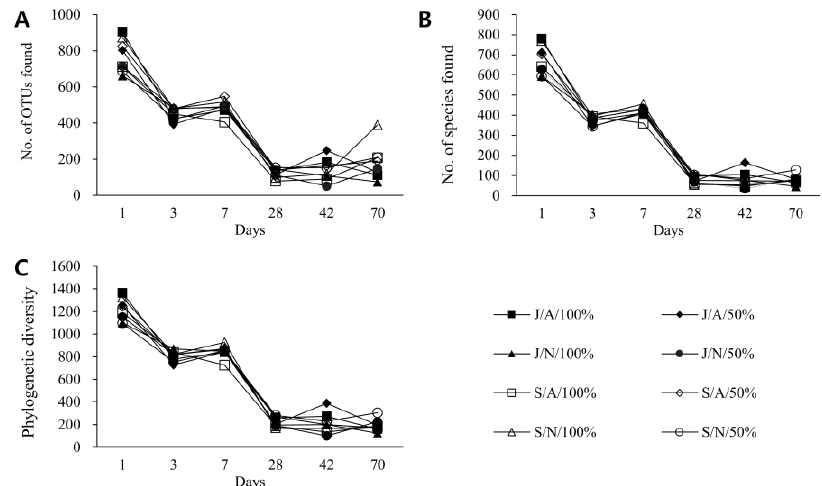
Figure 3. Analysis of diversity of bacterial communities in vinegar according to fermentation time and condition. As fermentation progressed, vinegar was sampled and DNA was extracted. The bacterial 16S rRNA gene was amplified, sequenced with NGS (Next-generation sequencing), and analyzed. ( A ) Sequences less than 97% similarity to other sequences were analyzed as different operational taxonomic units (OTUs). ( B ) Among them, the number of unique species identified based on the reference database was examined. ( C ) Measures of biodiversity incorporating phylogenetic differences between species were also studied. Please see the “ Materials and Methods ” section for eight different fermentation conditions. For example, the first condition, ‘ J/A/100%, ’ means that 100% bokbunja undiluted solution is fermented in a Gochang jar with oxygen/temperature adjusted.